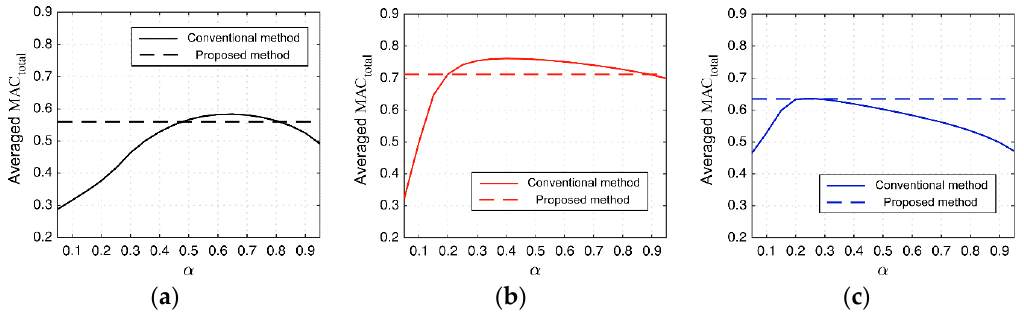
Figure 4. Averaged MAC total using short-time Fourier transform (STFT) with a 25-ms Hamming window, 10-ms hop length, and 512-point FFT for 1680 speech samples of conventional and proposed